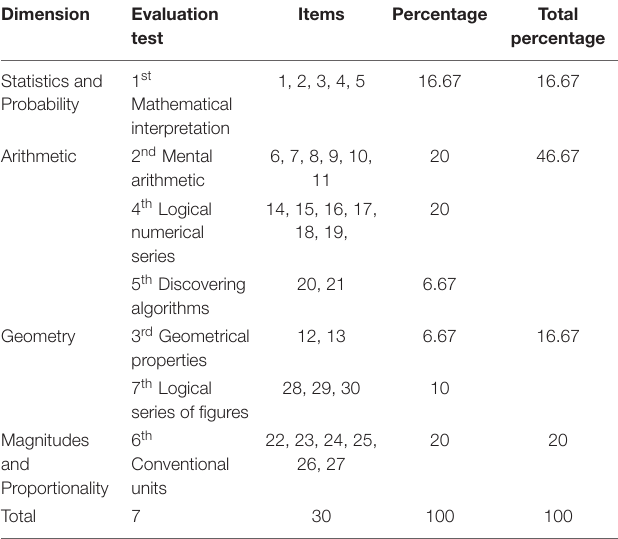
mathematical thinking and reasoning. These students can